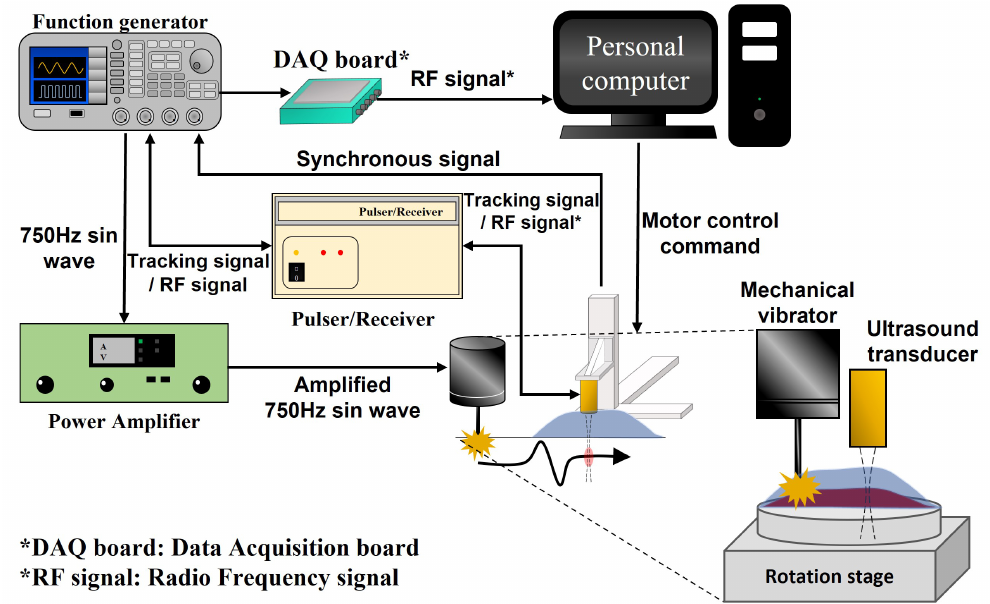
Figure 1. Experimental setup for the mechanical wave imaging